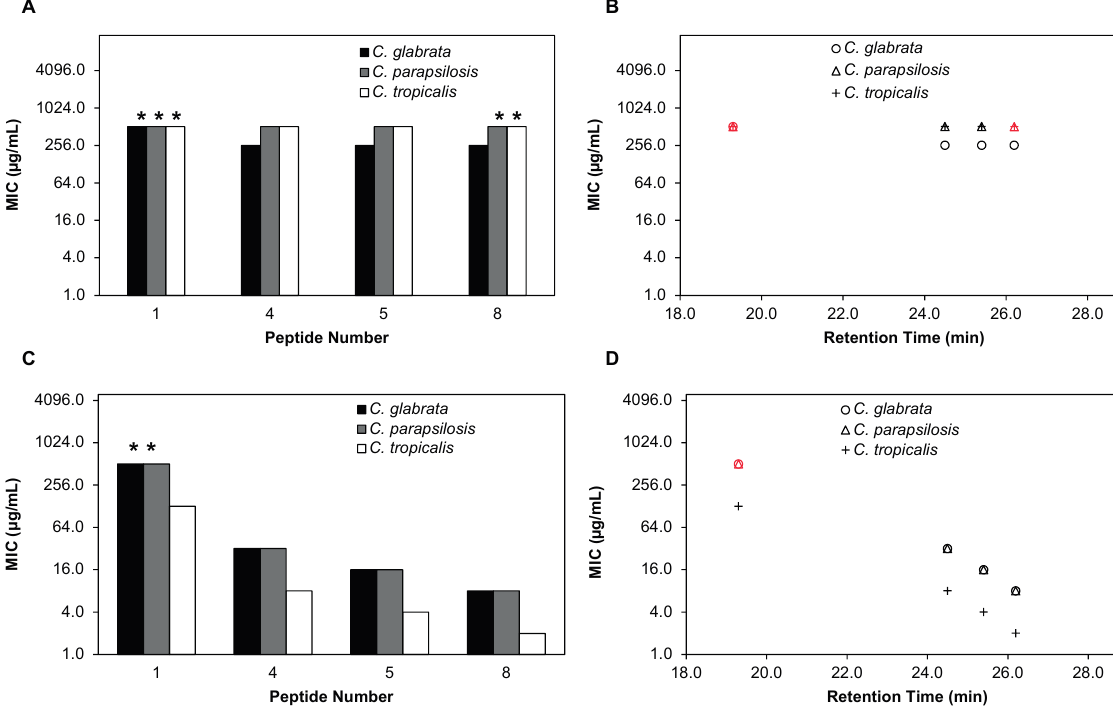
Figure 6. Antifungal activities of β -peptides against C. glabrata, C. parapsilosis and C. tropicalis biofilms. ( A ) Mature biofilms were formed by incubating C. glabrata (black bars) , C. parapsilosis (grey bars), and C. tropicalis (white bars) cells (10 6 cells/mL) for 48 h. Planktonic cells were removed, biofilms were washed, and 2-fold dilutions of β -peptides were added and incubated for an additional 48 h. β -Peptide MICs were quantified using an XTT assay to compare the absorbance at 490 nm for β -peptide-treated samples and untreated samples. ( B ) Plot of biofilm MICs versus RP-HPLC retention times of β -peptides 1 , 4 , 5 and 8 against C. glabrata (circles) , C. parapsilosis (triangles), and C. tropicalis (plus signs). ( C ) MICs against C. glabrata (black bars) , C. parapsilosis (grey bars), and C. tropicalis (white bars) biofilm formation were determined by incubating cells (10 6 cells/mL) with 2-fold dilutions of β -peptides for 48 h. Planktonic cells were removed, biofilms were washed, and β -peptide susceptibility was assessed using an XTT assay to compare the absorbance at 490 nm for β -peptide-treated samples and untreated samples. ( D ) Plot of MICs for inhibition of biofilm formation versus RP-HPLC retention times of the β -peptides 1 , 4 , 5 and 8 against C. glabrata (circles) , C. parapsilosis (triangles), and C. tropicalis (plus signs) . Experiments were performed on at least two independent days with three replicates each. Asterisks ( * ) and red symbols indicate that MIC was > 512 µg/mL, the highest concentration of peptide